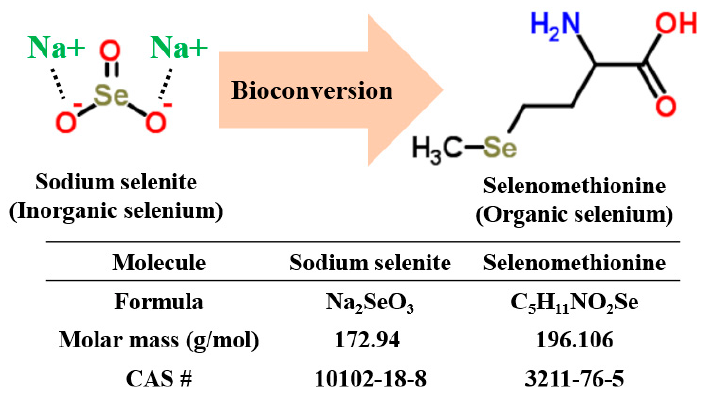
Figure 1. Bioconversion of inorganic selenium (sodium selenite) using microorganisms responsible for organic selenium (selenomethionine) production.